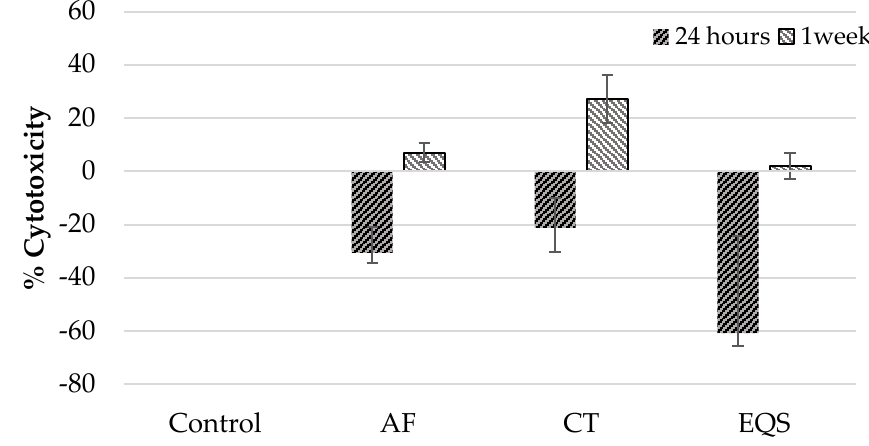
Figure 2. Cytotoxicity of CRs on hPDLF cells at 24 h and one-week time periods (mean ± SD). Accordingly, viabilities of hPDLF cells in contact with AF, CT, and EQS composite discs were lower at one week compared to 24 h (AF; p = 0.02, CT; p = 0.02, EQS; p = 0.04) (Table 4).